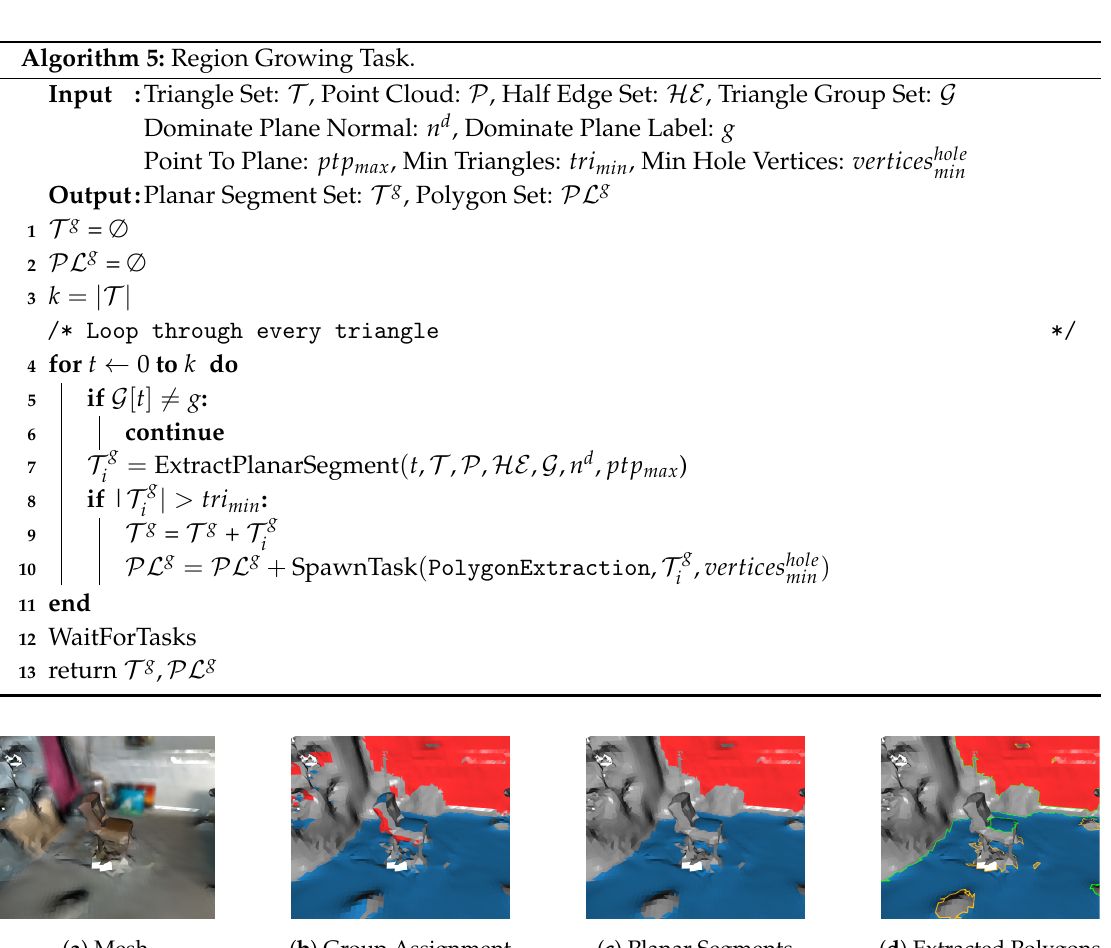
Algorithm 5: Region Growing Task.